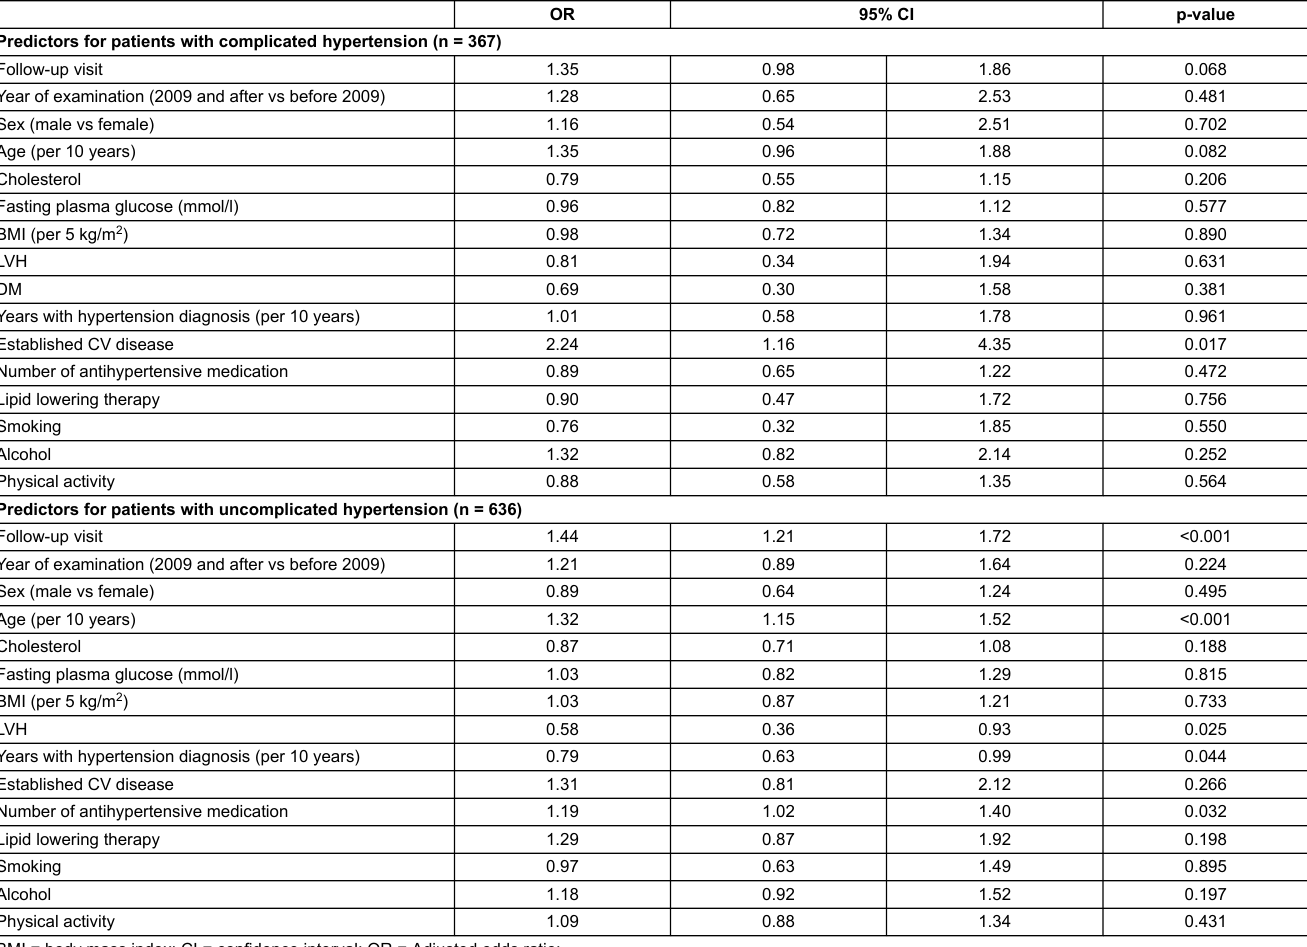
Table 4: Pooled multivariable logistic mixed-effect regression results describing the association between blood pressure goal attainment and demographic/health-related vari- ables in (1) patients with complicated hypertension (n = 367) and (2) patients with uncomplicated hypertension (n = 636). OR 95%